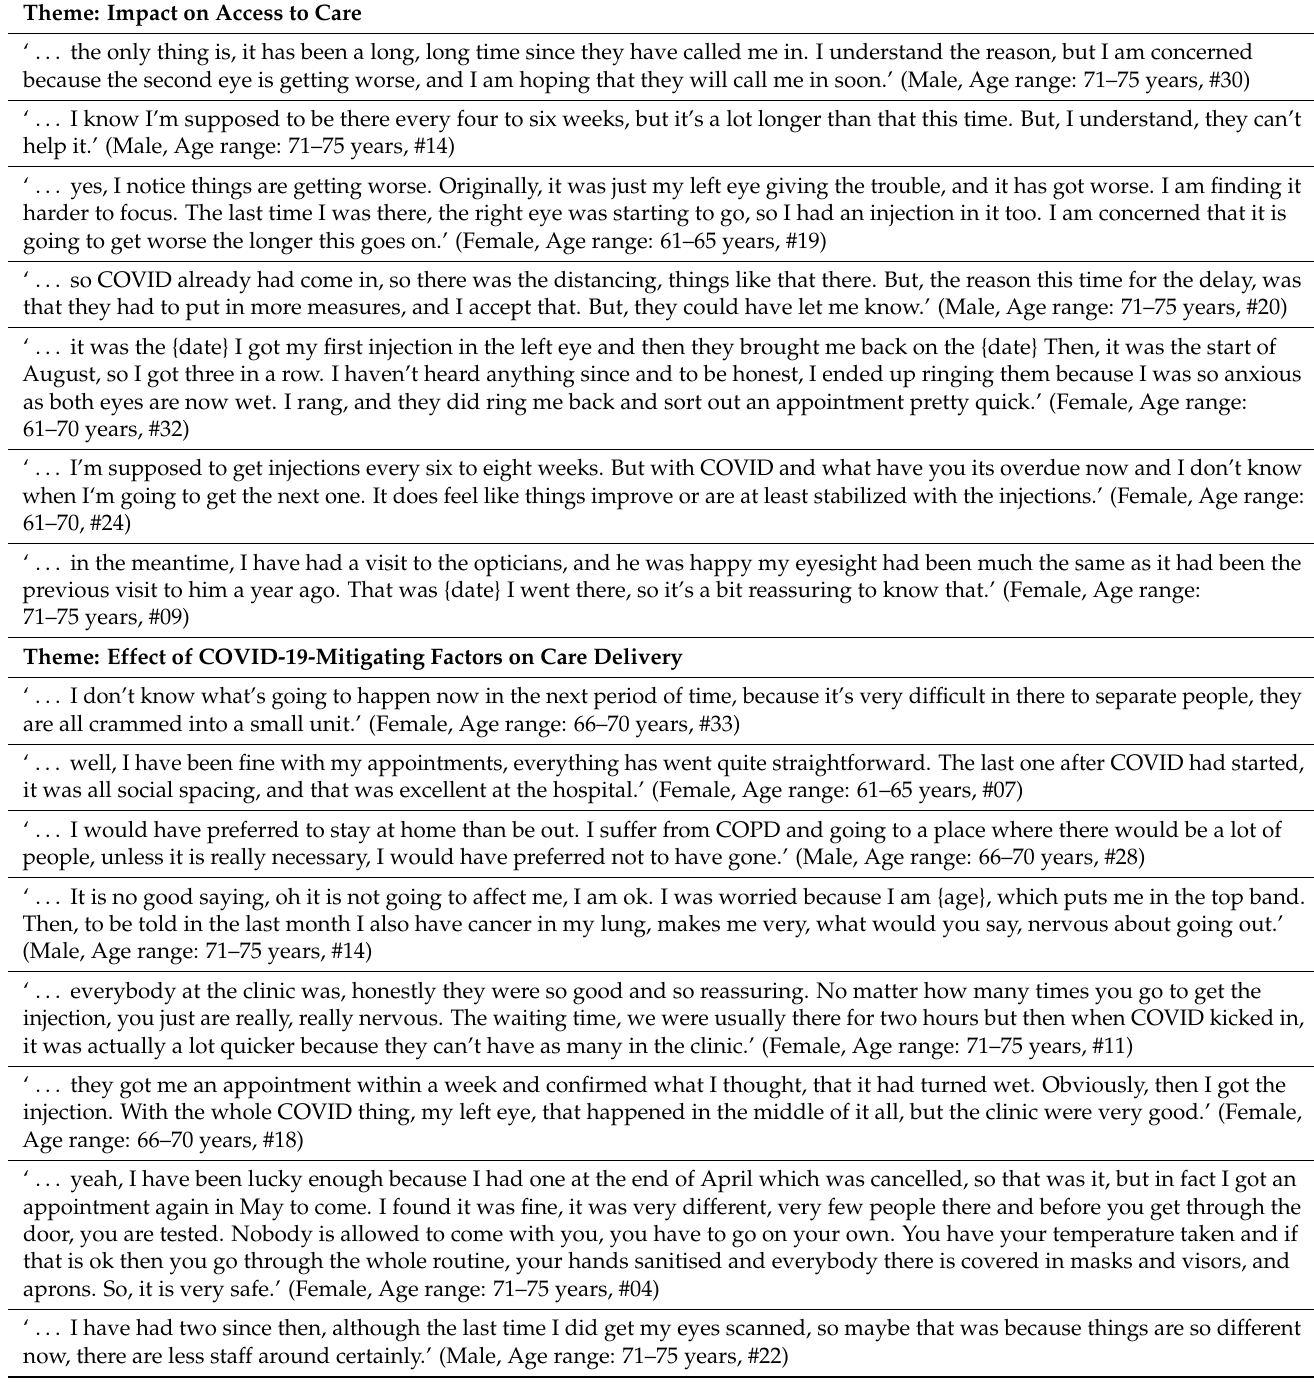
Table 2. Selected quotes related to views on the impact of COVID-19 on access to care and the effect of mitigating factors on care